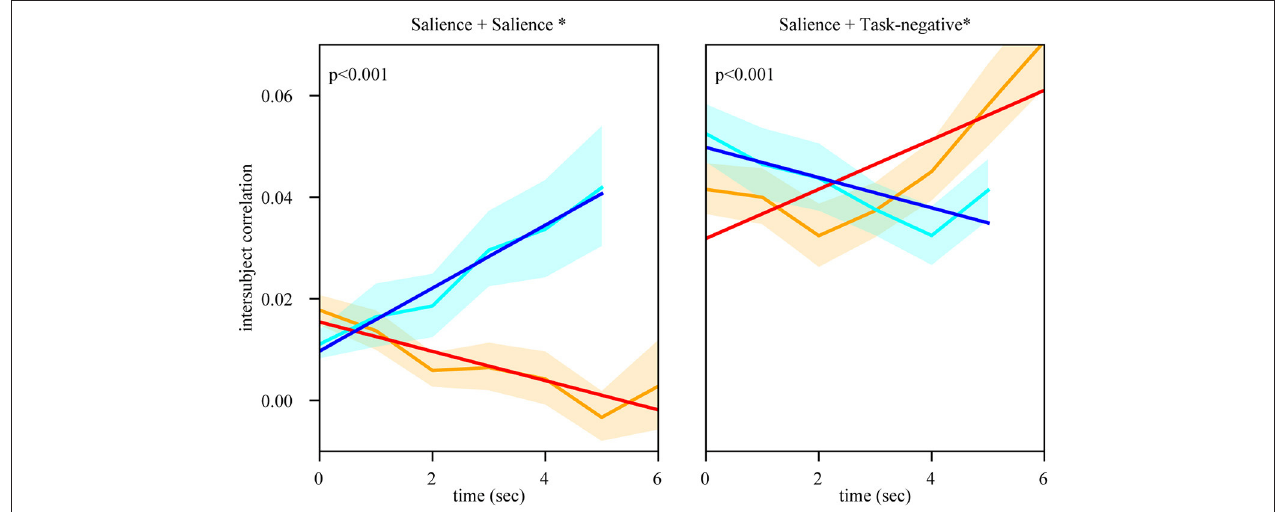
FIGURE 10 | Temporal evolution of intersubject negative weights during approach and retreat segments. Within the salience network, negative weights increased during retreat and decreased during approach. Between the salience and task-negative networks, negative weights increased during approach and decreased during retreat. In both cases, the dynamic pattern of negative functional connectivity was the opposite of what was observed for positive weights (compare with Figure 5 ). Conventions as in Figure 5